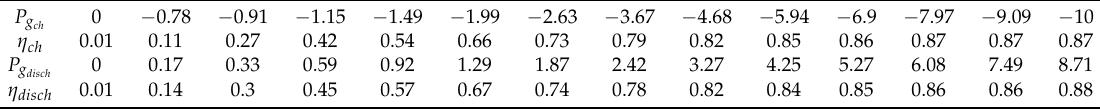
Table 1. Bidirectional 10 kW DC charger efficiency